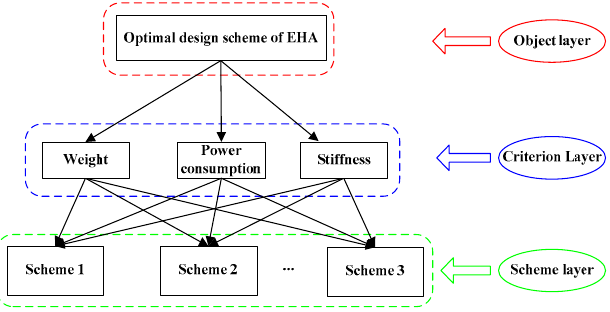
Figure 4. Three ‐ level hierarchical framework for an EHA. Figure 4. Three-level hierarchical framework for an